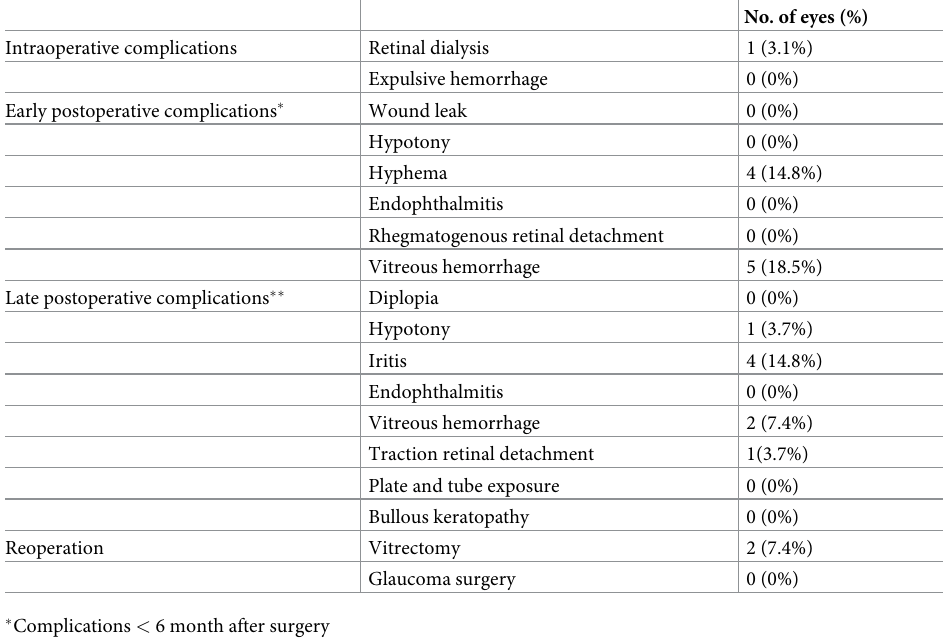
Table 3. Intraoperative complications, postoperative complications, and